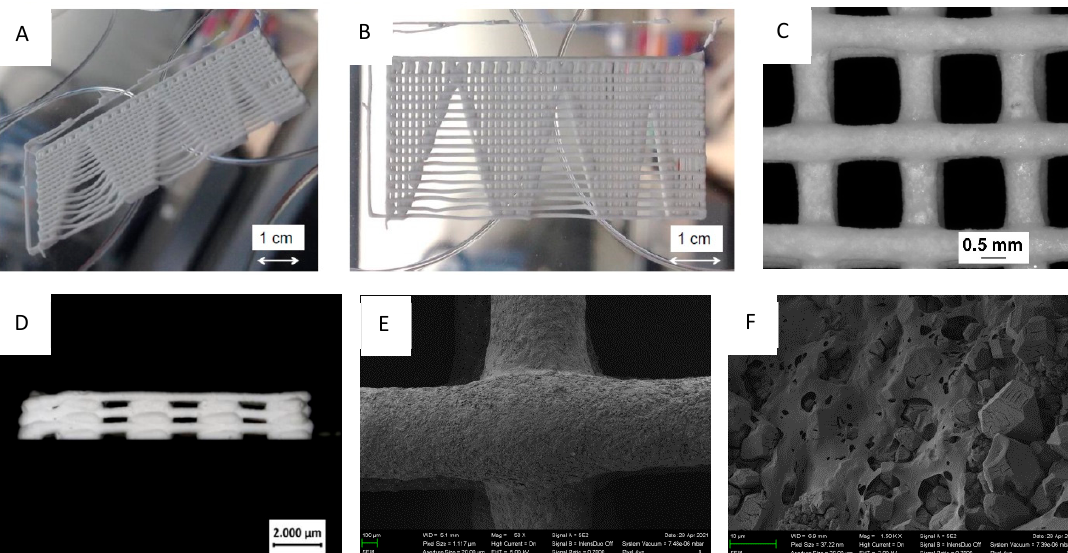
Figure 7. ( A , B ) printed structure to determine the maximum distance at which strands become unstable; ( C , D ) top and side view stereomicroscopic images of a six-layered 12 × 12 mm scaffold printed with a 0.41 mm cannula and a strand distance of 1.5 mm, ( E , F ) SEM images of two crossing strands at different magnifications.